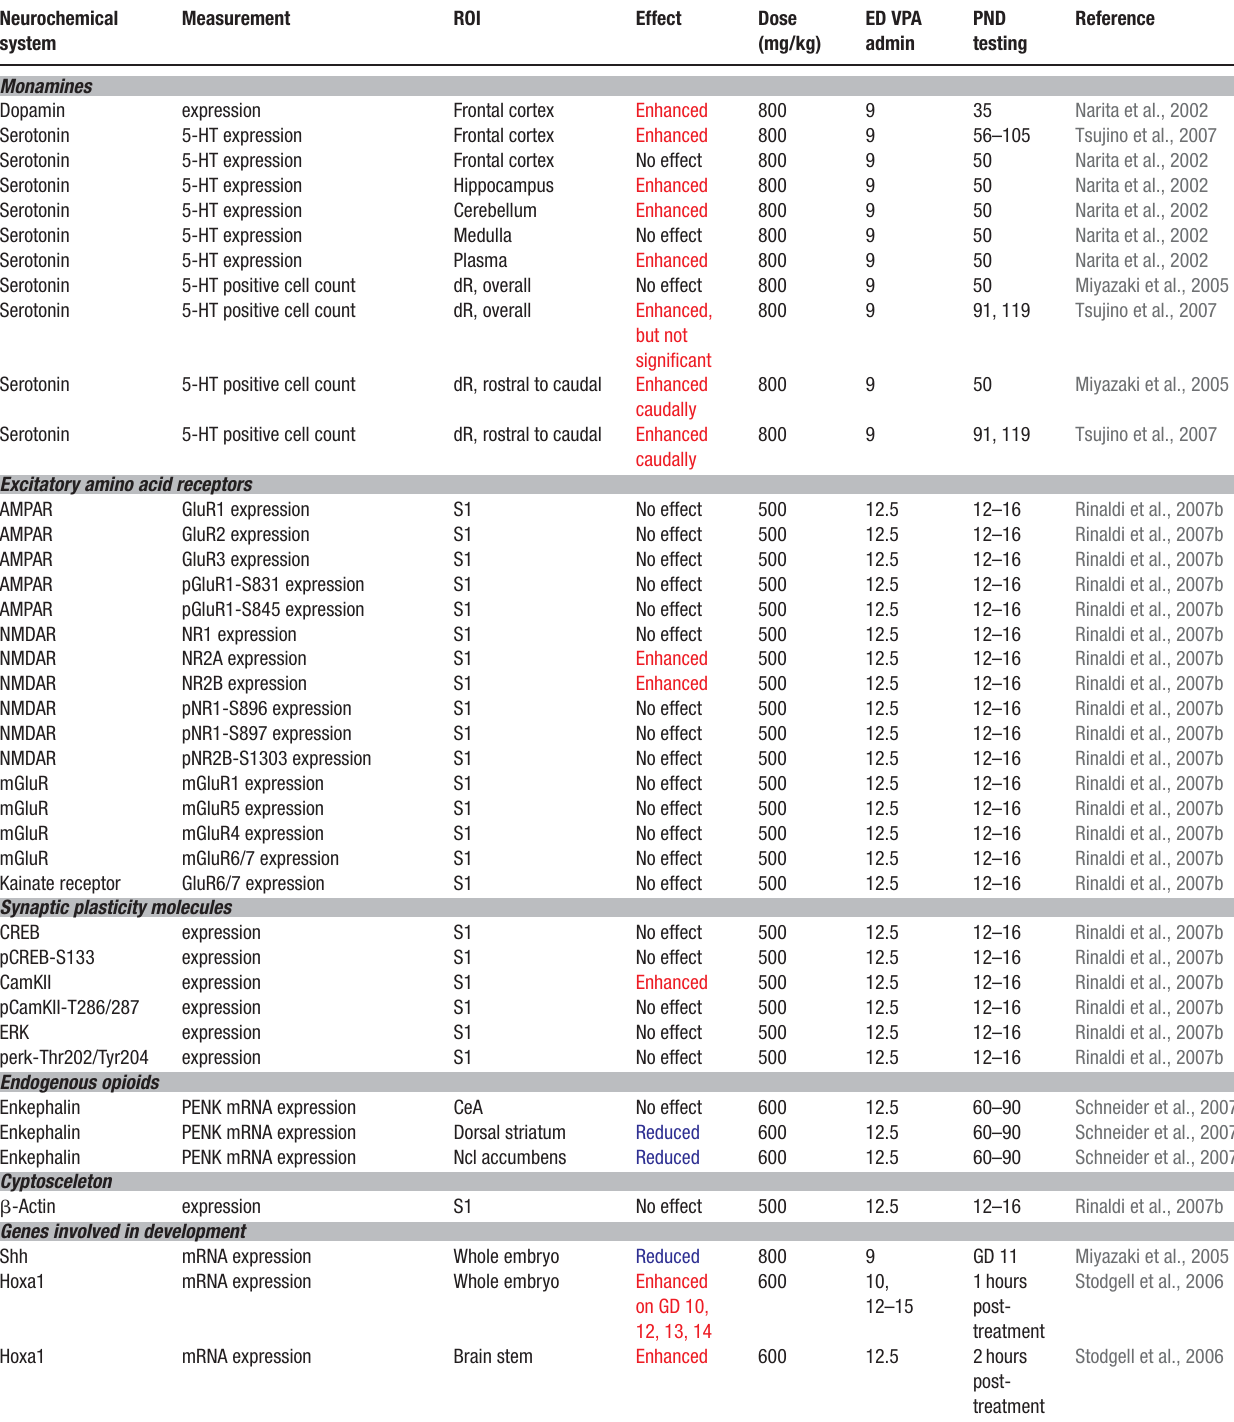
Table 3 . Neurochemical and genetic alterations in the VPA rat model of